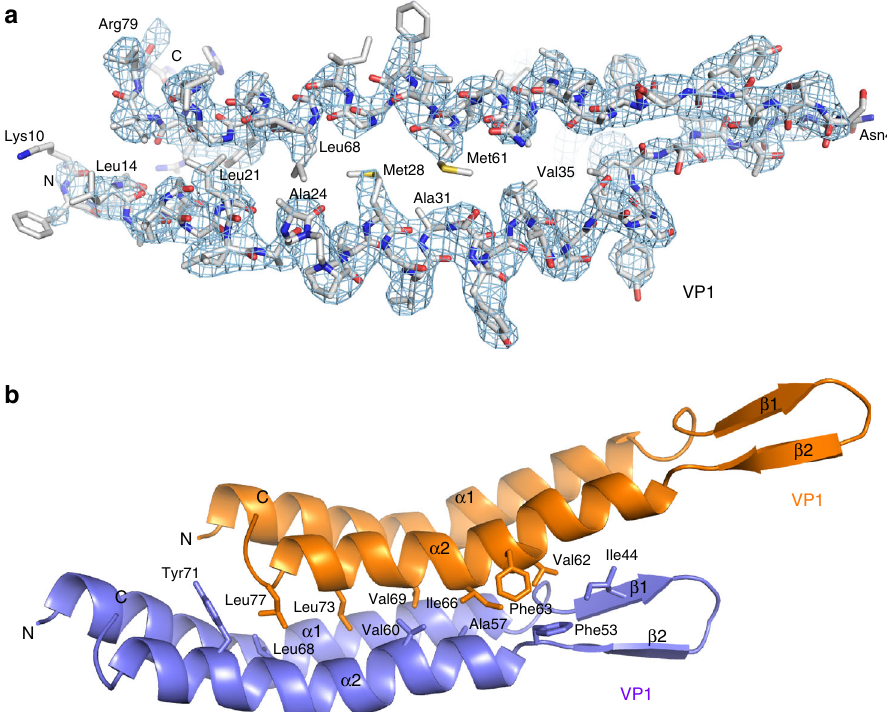
Fig. 2 Interactions within and between VP1 subunits. a The cryo-EM density (mesh) and corresponding model (sticks) of VP1 are shown. In addition to the positively charged residues at the N (Lys9) and C (Arg79) termini and the putative glycosylation site at Asn47, key residues involved in intramolecular interactions are labeled. b Two VP1 molecules are rendered as a ribbon in orange and blue. Residues involved in intermolecular contacts between two neighboring VP1 subunits are labeled. These residues create multiple hydrophobic contacts and a large